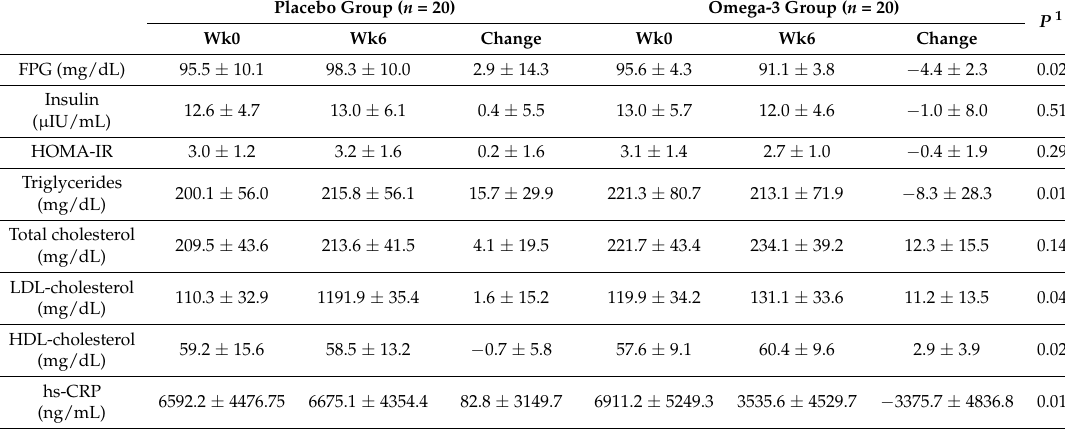
Table 3. Metabolic profiles at baseline and 6 weeks after the intervention in patients with gestational diabetes mellitus.